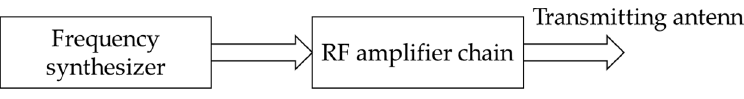
Figure 3. Simplified structure block diagram of radar transmitter.